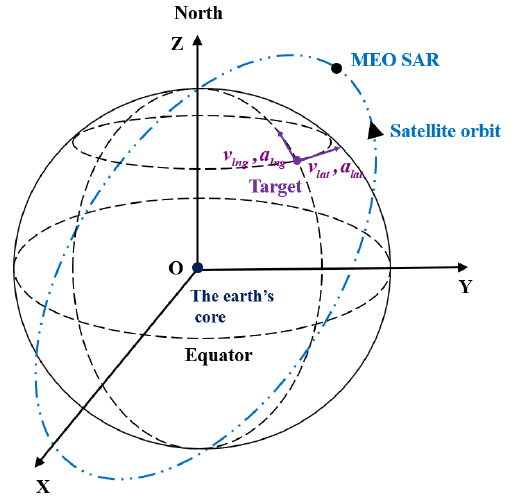
Figure 1. MEO SAR geometry. Figure 1. MEO SAR Based on the kinematics, the coordinates of the satellite in the ECR coordinate system can be expressed as [20]